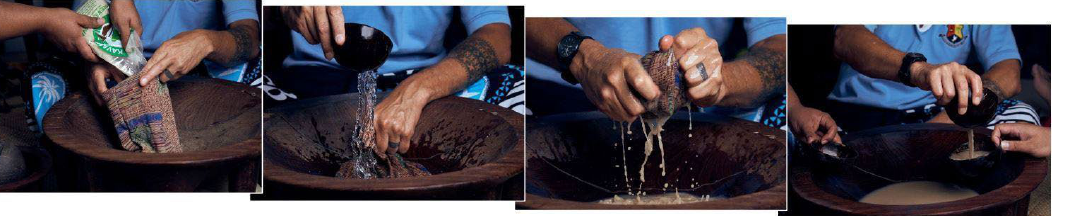
Figure 1: Dry pounded kava root being mixed for drinking (photographer: Todd Henry, 2019)